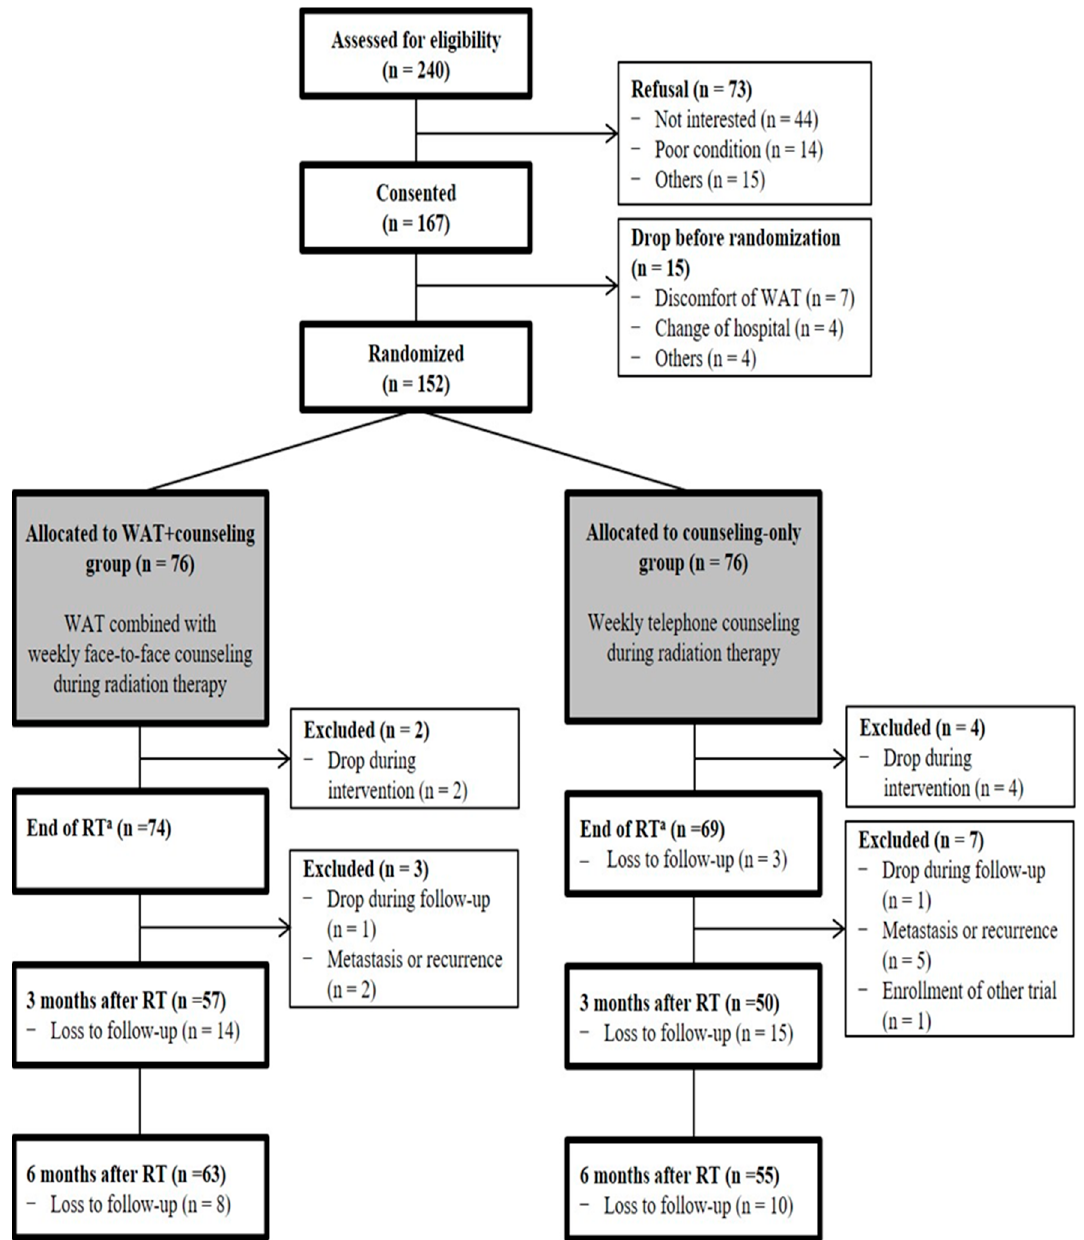
Figure 1. Study flow diagram. The number of participants at each time point reflects those who had complete questionnaire data. Participants who dropped out, had metastasis/recurrence, or enrolled in other trial were permanently excluded from the study, whereas other participants remained in the study and were eligible for measurement at the next time. a Primary endpoint; RTx, radiation therapy, WAT, wearable activity tracker.